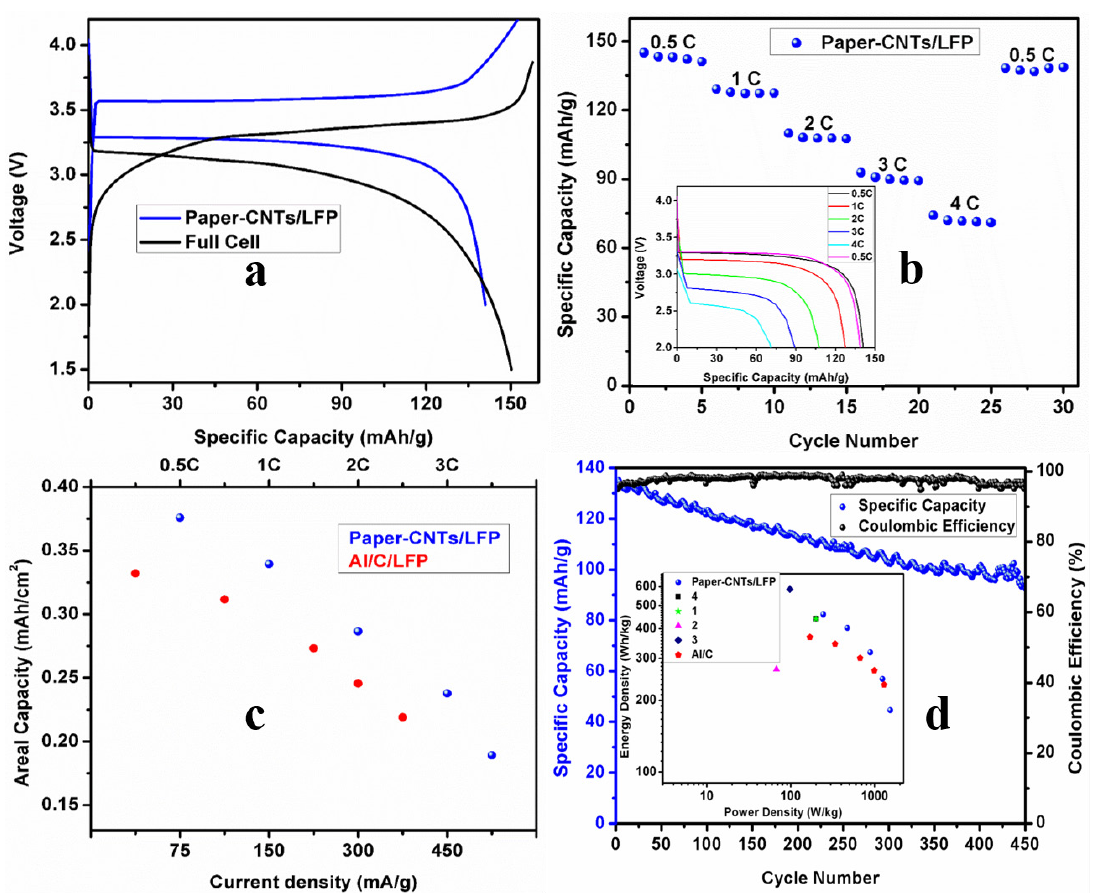
Figure 3: (a) Gravimetric charge-discharge curves, (b) C-rate cycling, (c) Areal capacities, and (d) Cycling performance of paper- CNTs/LiFePO 4 electrode. Inset in panel (b) depicts the representative galvanostatic discharge curves for the 5 th cycle of each C-rate series. Inset in panel (d) is the Ragone plot and the numbers in the legend in the inset of Figure 3d denote references for other works that used paper-based